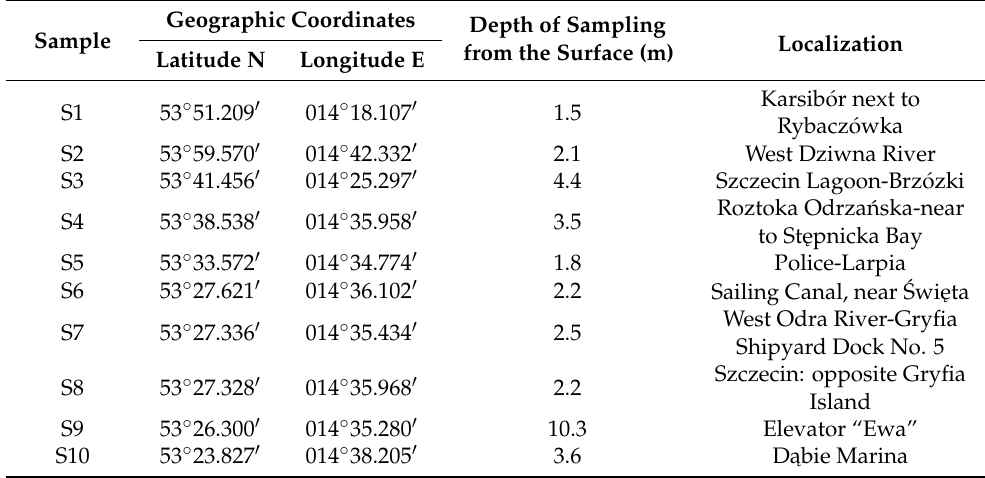
Table 3. Geographic coordinates, depth of sampling from the water surface, and localization name of sediments collected from the Odra River estuary. Geographic Coordinates Depth of Sampling Sample from the Surface